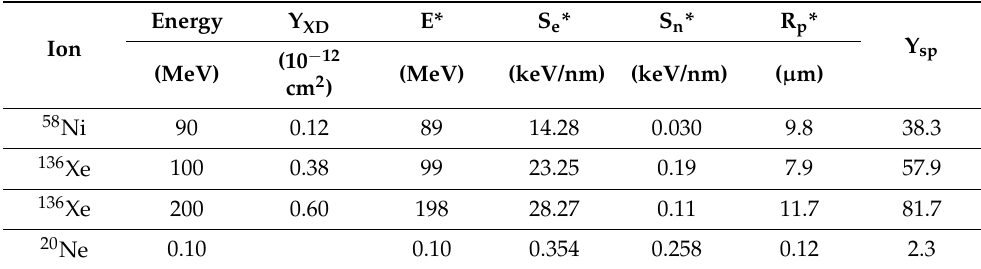
Figure 5. XRD intensity normalized to unirradiated films of Fe 2 O 3 as a function of ion fluence for 90 MeV Ni ( (cid:3) , • , ∇ , (cid:78) ), 100 MeV Xe (o, ∆ , +, x) and 200 MeV Xe ( • , ♦ , (cid:72) , (cid:84) ) ions. Diffraction peaks at ~33 ◦ of Fe 2 O 3 films on C-Al 2 O 3 substrate ( (cid:3) (90 MeV Ni), o (100 MeV Xe), • (200 MeV Xe)), ~36 ◦ of films on C-Al 2 O 3 ( • (90 MeV Ni), + (100 MeV Xe), ♦ (200 MeV Xe)), ~33 ◦ of films on SiO 2 glass substrate ( ∇ (90 MeV Ni), ∆ (100 MeV Xe), (cid:72) (200 MeV Xe)) and ~36 ◦ of films on SiO 2 glass substrate ( (cid:78) (90 MeV Ni), x (100 MeV Xe), (cid:84) (200 MeV Xe)). Data of 100 MeV Xe are from [60]. Linear fit is indicated by dotted lines. An estimated error of XRD intensity is 10%. Table 4. XRD data of Fe 2 O 3 films. Ion, energy (E in MeV), XRD intensity degradation (Y XD ), E* = E- ∆ E (energy loss in carbon foil of 100 nm) (MeV) and electronic (S e *) and nuclear (S n *) stopping powers in keV/nm and projected range R p * ( µ m) calculated using SRIM2013. Sputtering yield Y sp from [60]. Results by low energy (100 keV Ne) ion are also